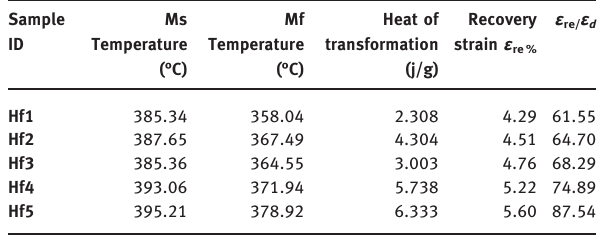
Table 2: Effect of Hf modification on SME and the recovered strain during two training cycles.